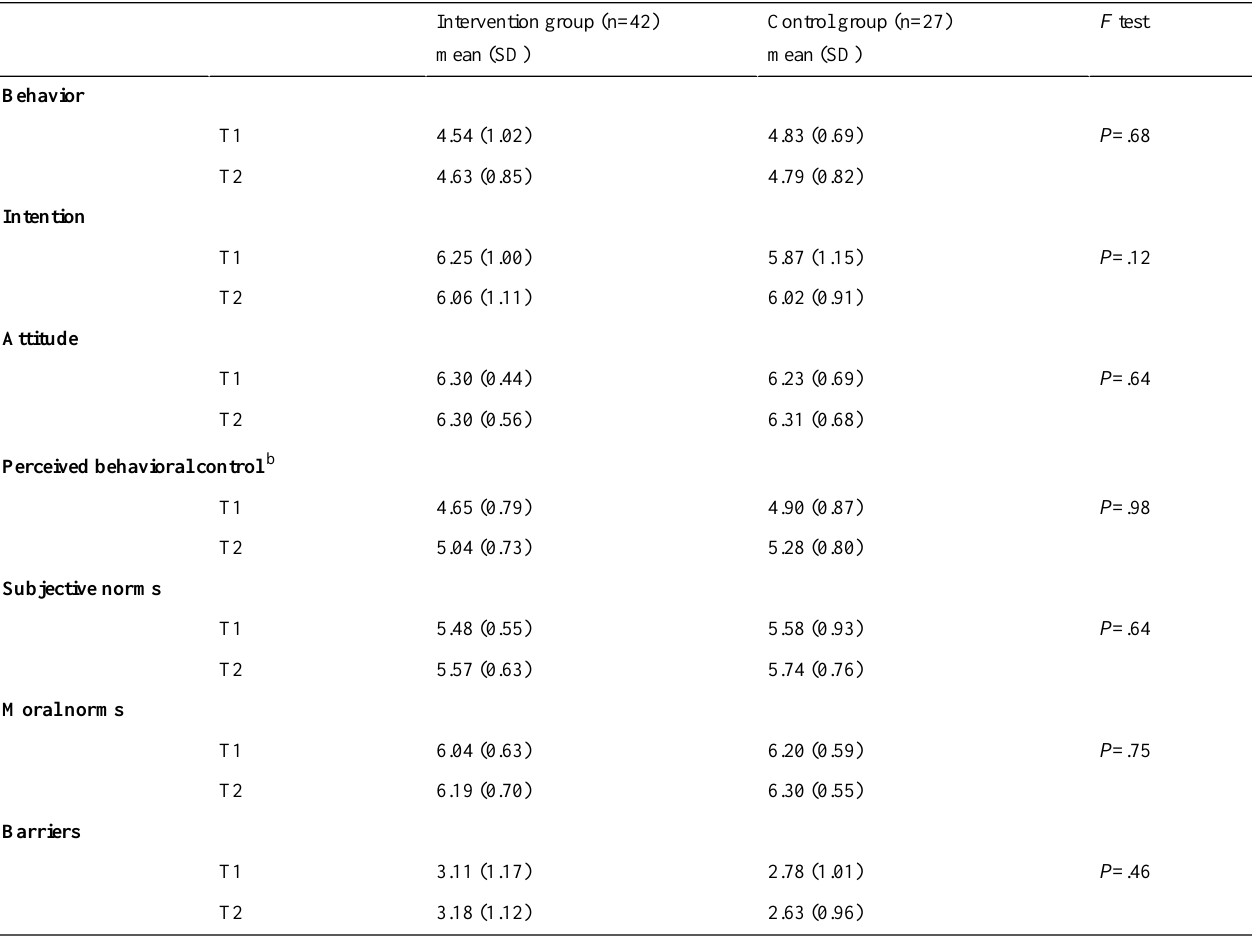
Table 2. Paired differences between intervention group and control group, measured at T1 and T2.